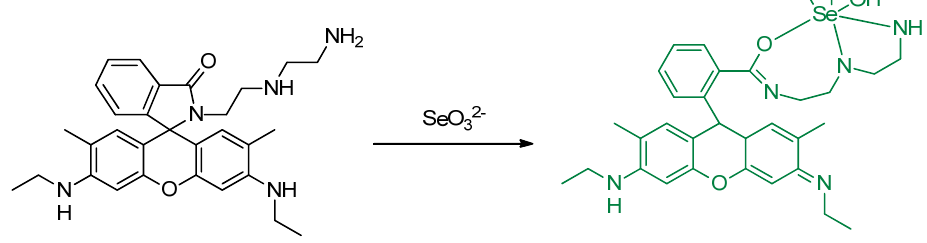
Figure 43. The structure of ABDO synthesized by Guan et al. and the binding of selenite analyte to achieve recognition with this probe.